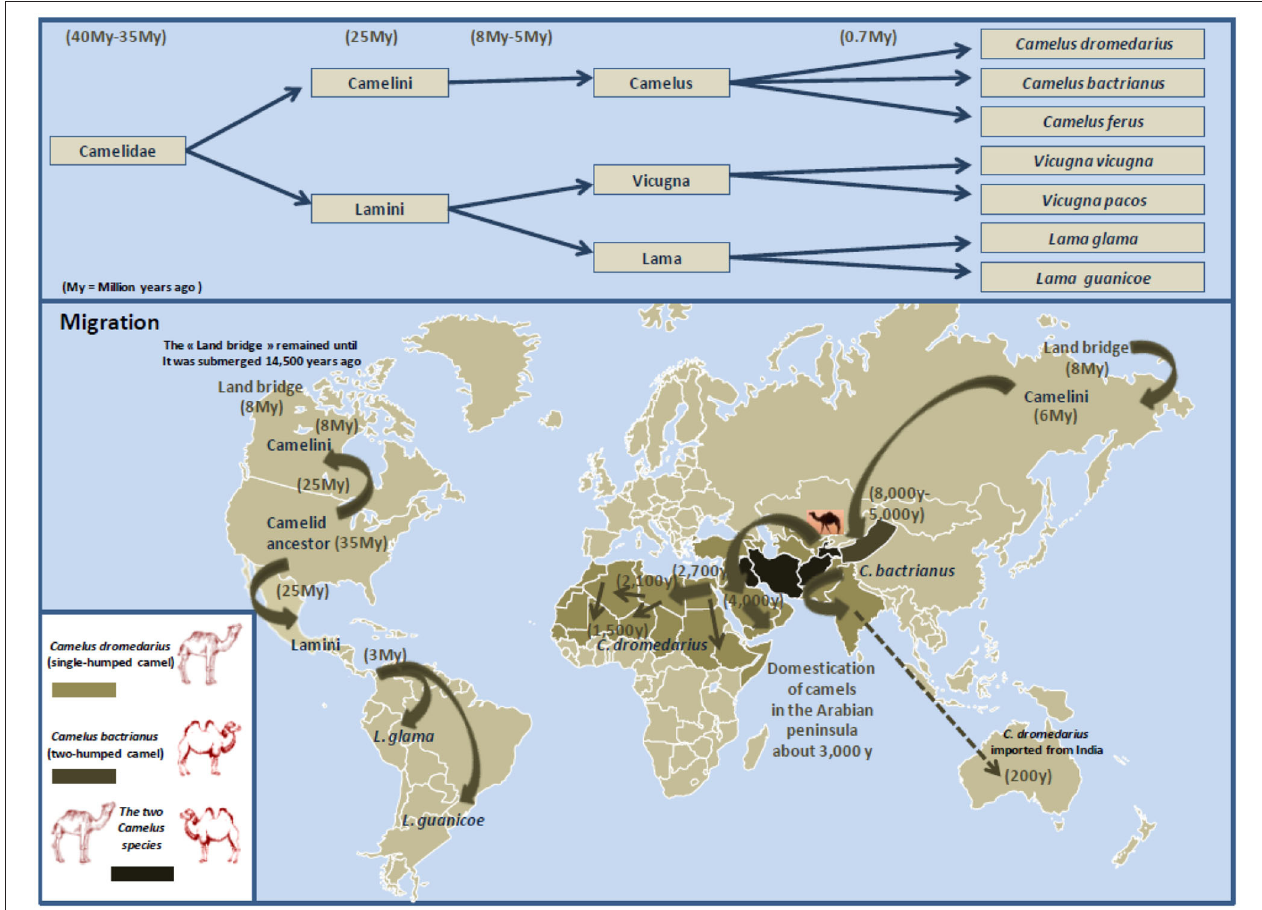
FIGURE 5 | Schematic representation of Camelidae evolution, migration, and domestication. The earliest known Camelidae, named Protylopus and Poebrotherium , appeared roughly 40 million years ago in the North American. During the transition from the Eocene to the Oligocene geological period (about 34 million years ago), the climate in North America is expected to have changed for cooler and drier, and Camelidae began to genetically diverge (407). This was supported by the discovery of the fossil of Paracamelus in Canada in 1913 where this ancestor of Camelus bactrianus and Camelus dromedarius was expected to have inhabited there about 3.5 million years ago when a warmer climate allowed forests to spread near the Arctic Circle ( 408). About 6 to 8 million years ago, Camelini gradually moved across the land that connected North America to Asia (this land bridge appeared some 8 million years ago, and it remained practicable until it was submerged about 14,500 years ago). According to Wu et al. ( 409), during the species evolution, they diverged into (i) large Camelidae (Camelini), which lived in North America and next moved westward across the land that connected North America with Asia, then Middle East and North Africa; and (ii) small Camelidae (Lamini), which dispersed South (currently South America). Subsequently about 5 to 8 million years ago, Camelini further evolved into Camelus , which include two species: Camelus bactrianus (the two-humped camel; weight: 600–1,000kg; size 1.6–1.8m) and Camelus dromedarius (the single-humped camel; weight: 400–600kg; size 1.6–2.0m). Lamini subdivided into two genera: Lama and Vicugna . The earliest evidence for the dromedary domestication is dated about 3,000 years ago near Abu Dhabi on the Arabian Gulf. Northern Arabian tribes began to use dromedary camels as riding animals (410). Dromedary camels were progressively domesticated in North Africa. Gift of camels was a source of camel spread around the Mediterranean. Currently, there are 33 million of domestic Camelus dromedarius living in semiarid and arid regions of Africa and the Middle East, 3 million of domestic Camelus bactrianus that live from the cold steppes of Central Asia to the border of Manchuria in China, and a small population (1,000 camels) of Camelus ferus, the Wild Bactrian, which survives in the Northwest China and the Gobi Desert of Mongolia ( Camelus ferus diverged from Camelus bactrianus about 0.7 million years ago) (411). Dromedary camels from India were also introduced in central Australia. Females are only able to conceive from 3 years old and can live up to 30 to 40 years